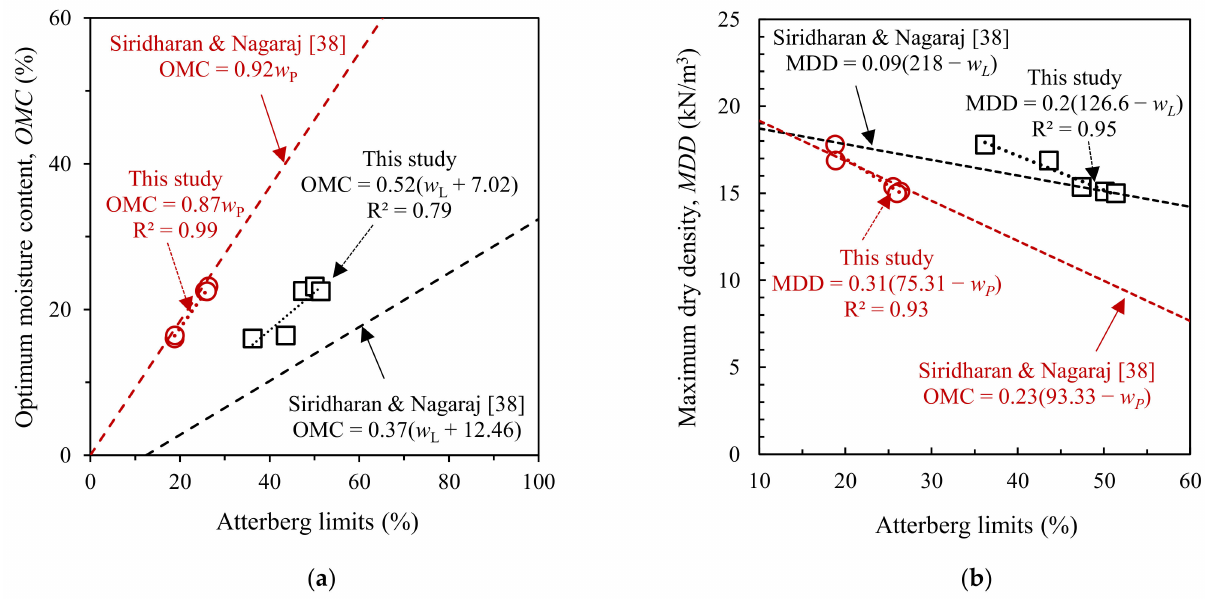
Figure 11. Relationships of compaction characteristics with consistency limits of sand-sediment mixes ( a ) OMC versus consistency limits ( b ) MDD versus consistency